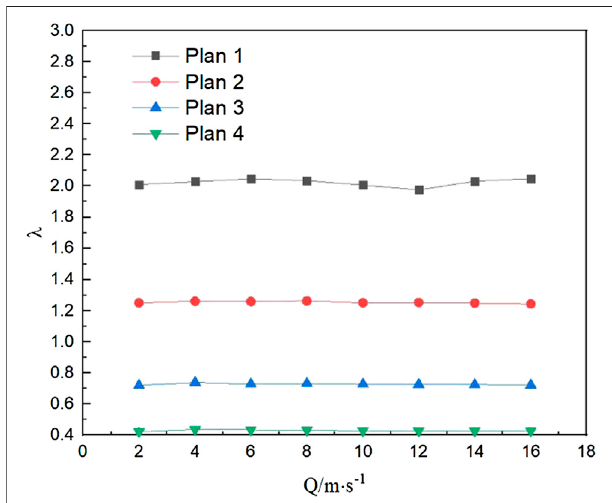
FIGURE 15 | Change of resistance coef fi cient along the